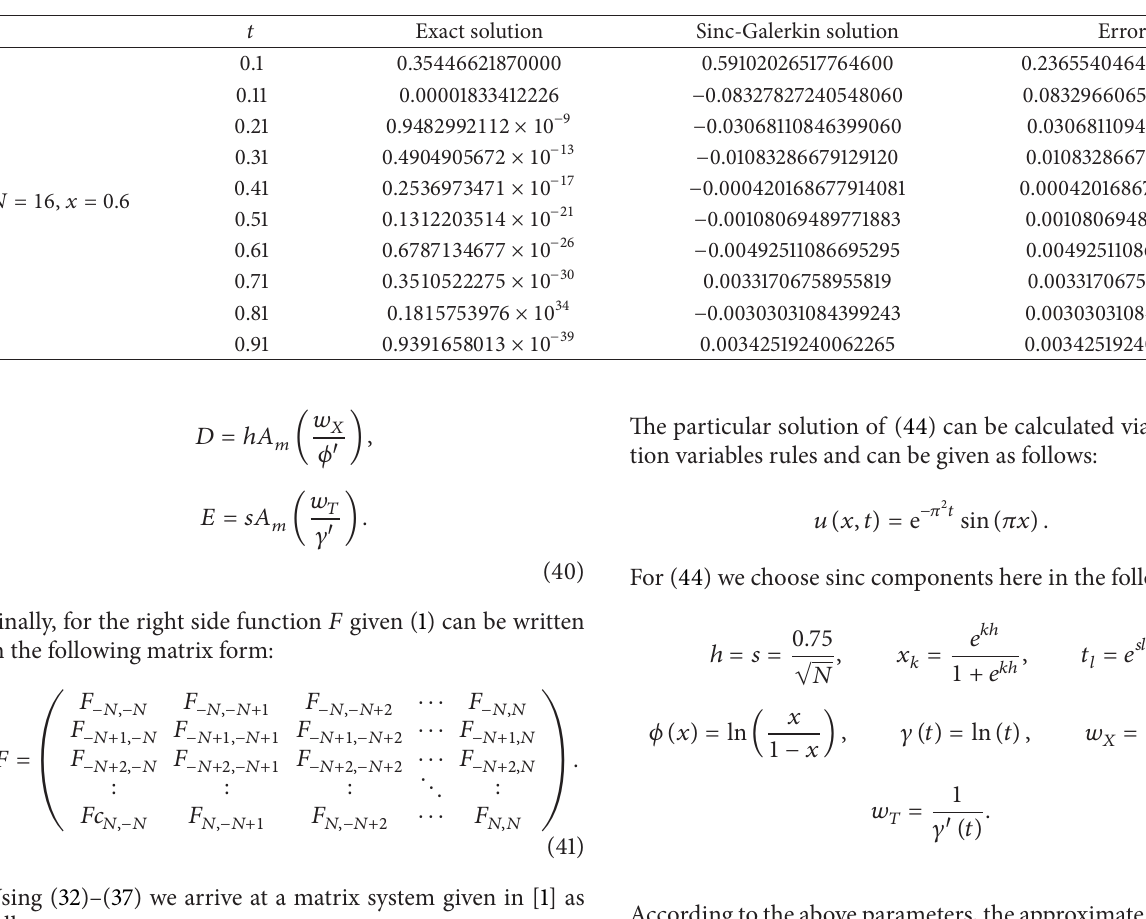
Table 2: Numerical